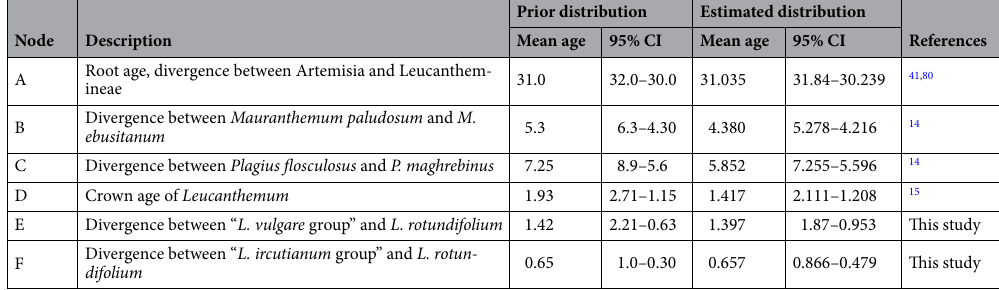
Table 1. Divergence times and 95% confidence intervals (CI) for nodes used for dating (nodes A–D from the 1st dataset and E–F from the 2nd dataset). All dating points follow a normal distribution. Numbers are in million